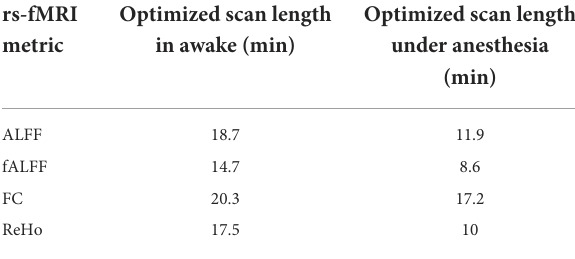
TABLE 3 List of optimized scan lengths for rs-fMRI metrics at derivative logarithmic function |dy/dx| = 0.01 [y = a + b